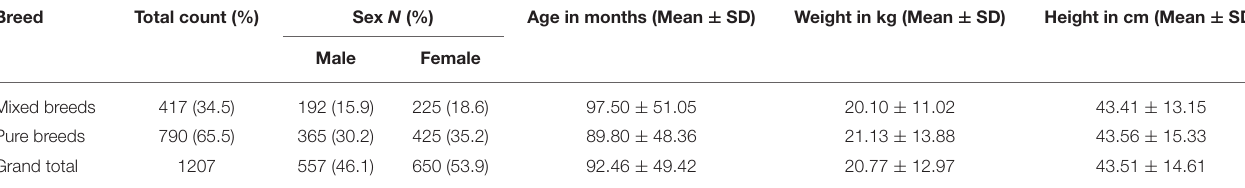
TABLE 1 | Descriptive statistics of the subjects, including sex, age, breed group, weight, and height